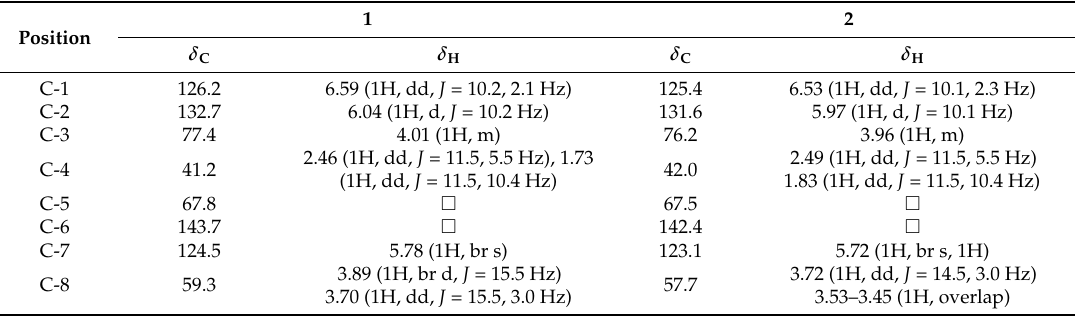
Table 1. 1 H- and 13 C-NMR data of Compounds 1 and 2 ( δ in ppm, CD 3 OD).